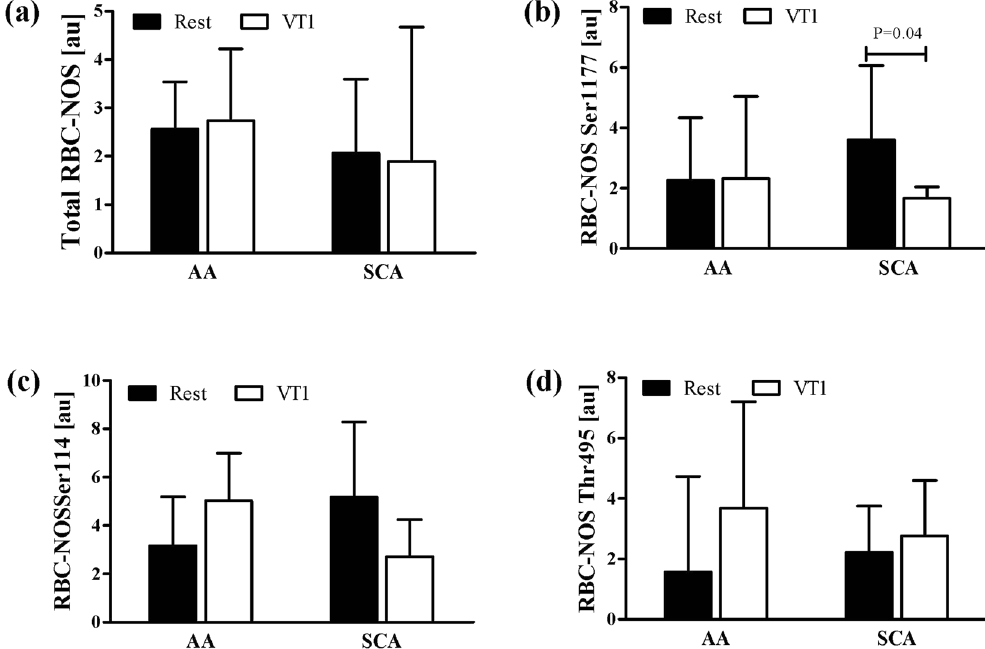
Figure 5. Exercise reduced activation of RBC-NOS enzyme in SCA. ( a ) Total RBC-NOS levels were comparable between the tested groups and not affected by exercise. ( b ) RBC-NOS serine 1177 staining was also comparable between SCA individuals and healthy controls (AA) at Rest but decreased at VT 1 in SCA patients. ( c ) RBC-NOS serine 114 and ( d ) RBC-NOS threonine 495 staining did not show differences between the tested groups and were unaffected by exercise. Data are mean ± s.d. of n = 5 AA and n = 6